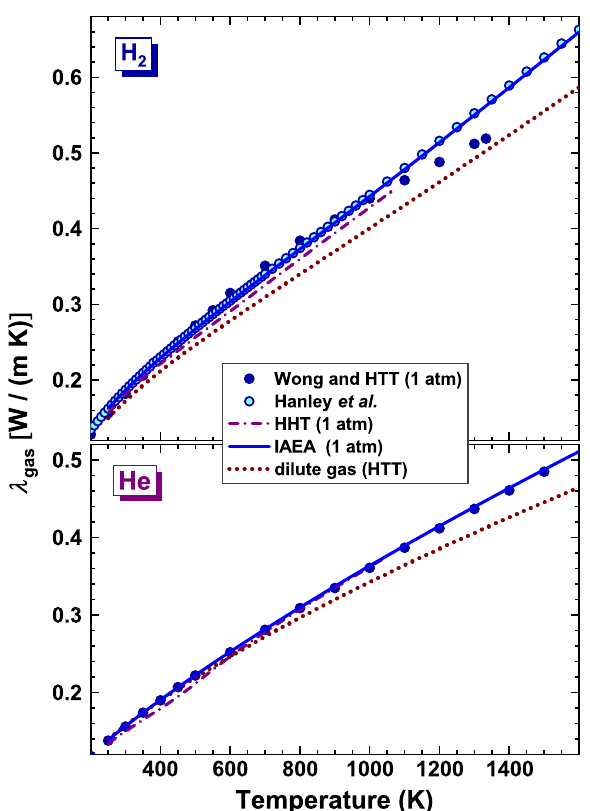
FIG. 6. Temperature dependencies of thermal conductivities for dilute H 2 and He gases (dotted lines) obtained using Eqs. (9) and (10) [23] are shown (upper and bottom panels, respectively). The tabulated data at the atmospheric pressure [22,23,51] (circles) and those obtained with the elaborated approximations ]49,52 ] (lines) denoted as (HHT) and (IAEA), respectively, are also shown for